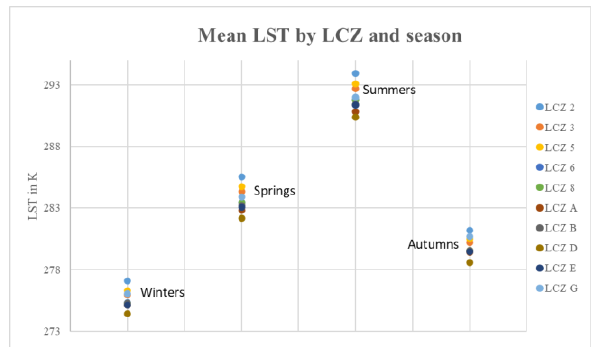
Figure 8 . Mean LST per LCZ and season from all MODIS data available.